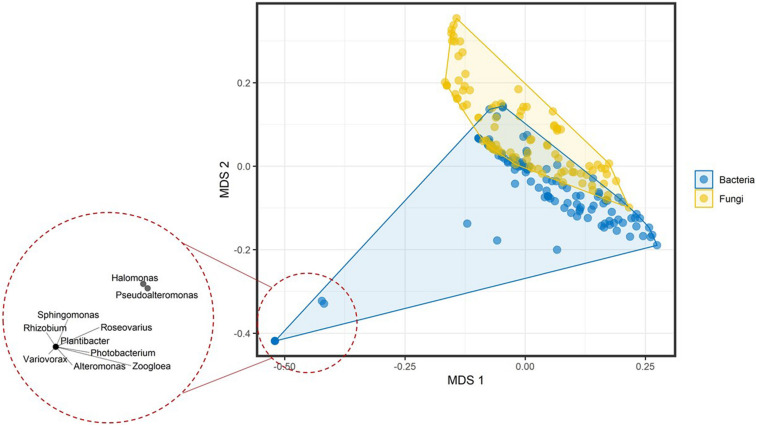
Multidimensional scaling plot of the volatilome profiles from bacterial and fungal genera differentiated at the domain (bacteria) and kingdom (fungi) level. The bottom left corner shows the clustering of the genera with very small volatilome sizes.